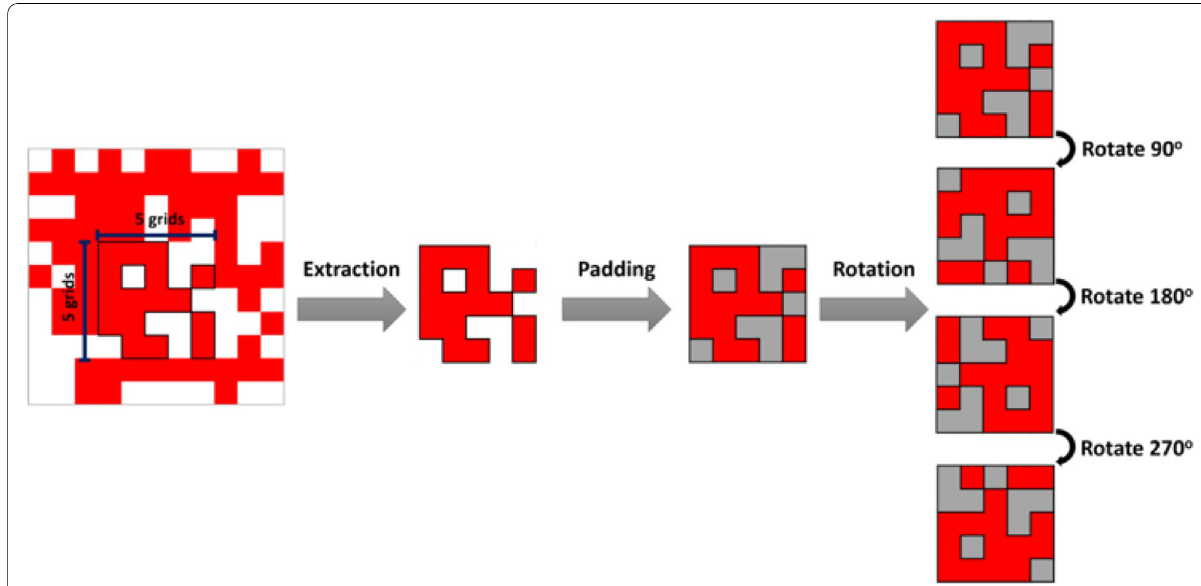
Fig. 3 Framework for generating CNN inputs by rotating